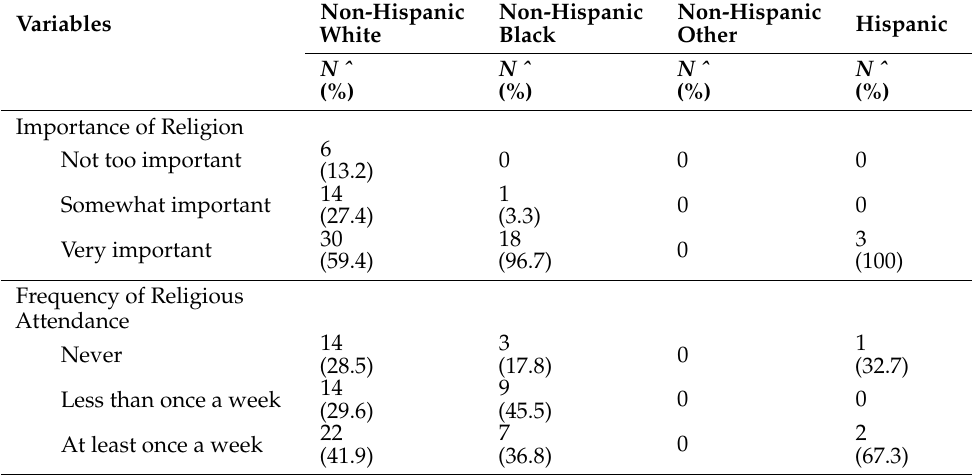
Table 2. Religious Frequencies Across